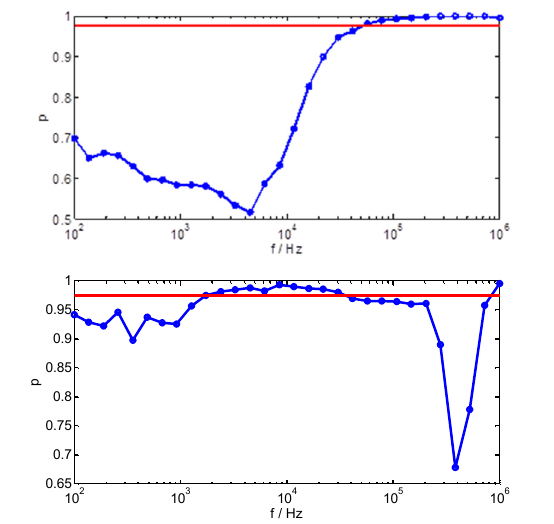
Fig.10: α -Quantiles for double sided t-test (A) magnitude of impedance and (B) phase. The red line indicated the significance level of 5% (0.975). The mean value is statistically different for frequencies with p-value above this